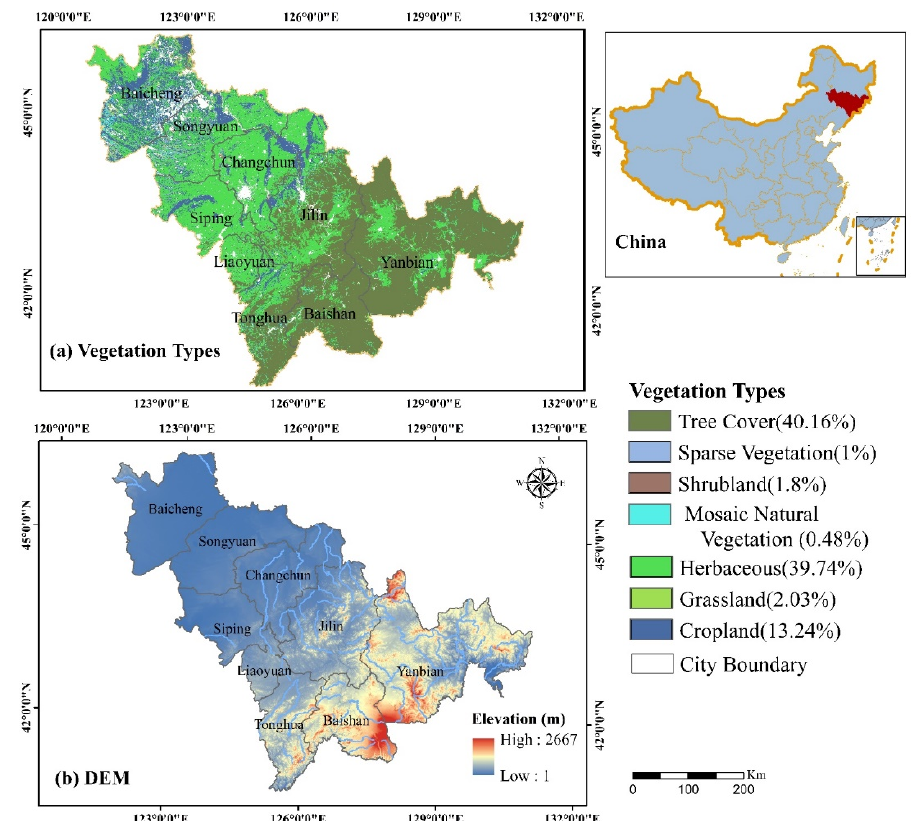
Figure 1. ( a ) Spatial distribution of land cover types in 2015 in Jilin Province (data from ESA CCI-LC); ( b ) the spatial distribution of elevation in Jilin Province (DEM from GDEMDEM data with a 30-m spatial resolution).